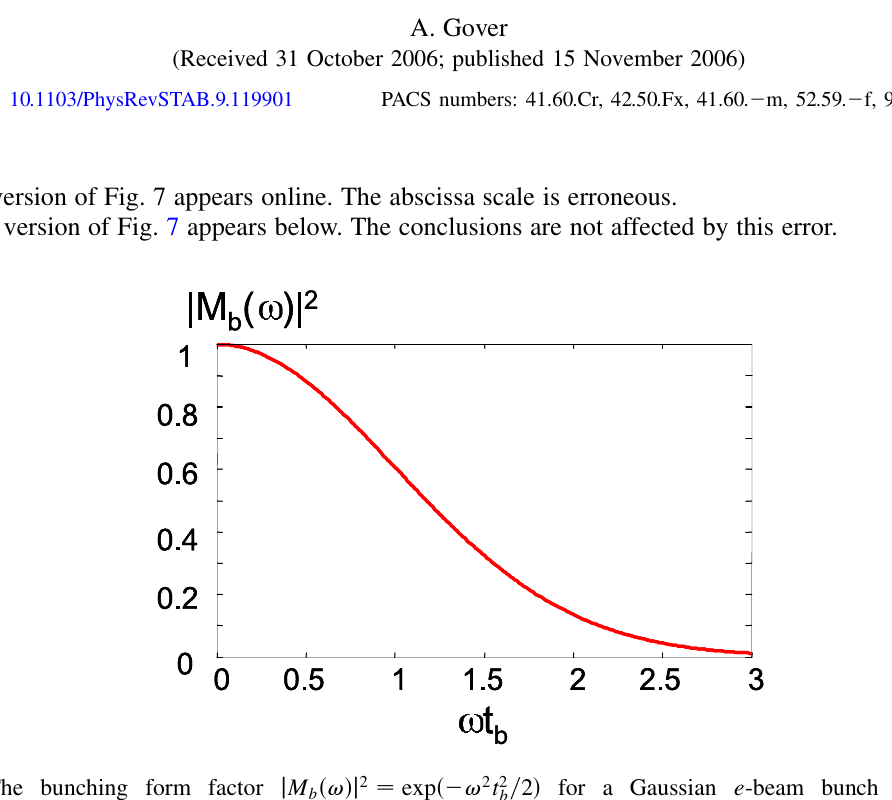
FIG. 7. (Color) The bunching form factor j M p (cid:3) = (cid:2) (cid:1)(cid:1)(cid:1)(cid:1) (cid:1) (cid:3) =t 2 t exp (cid:2)(cid:1) t 2 b b 0